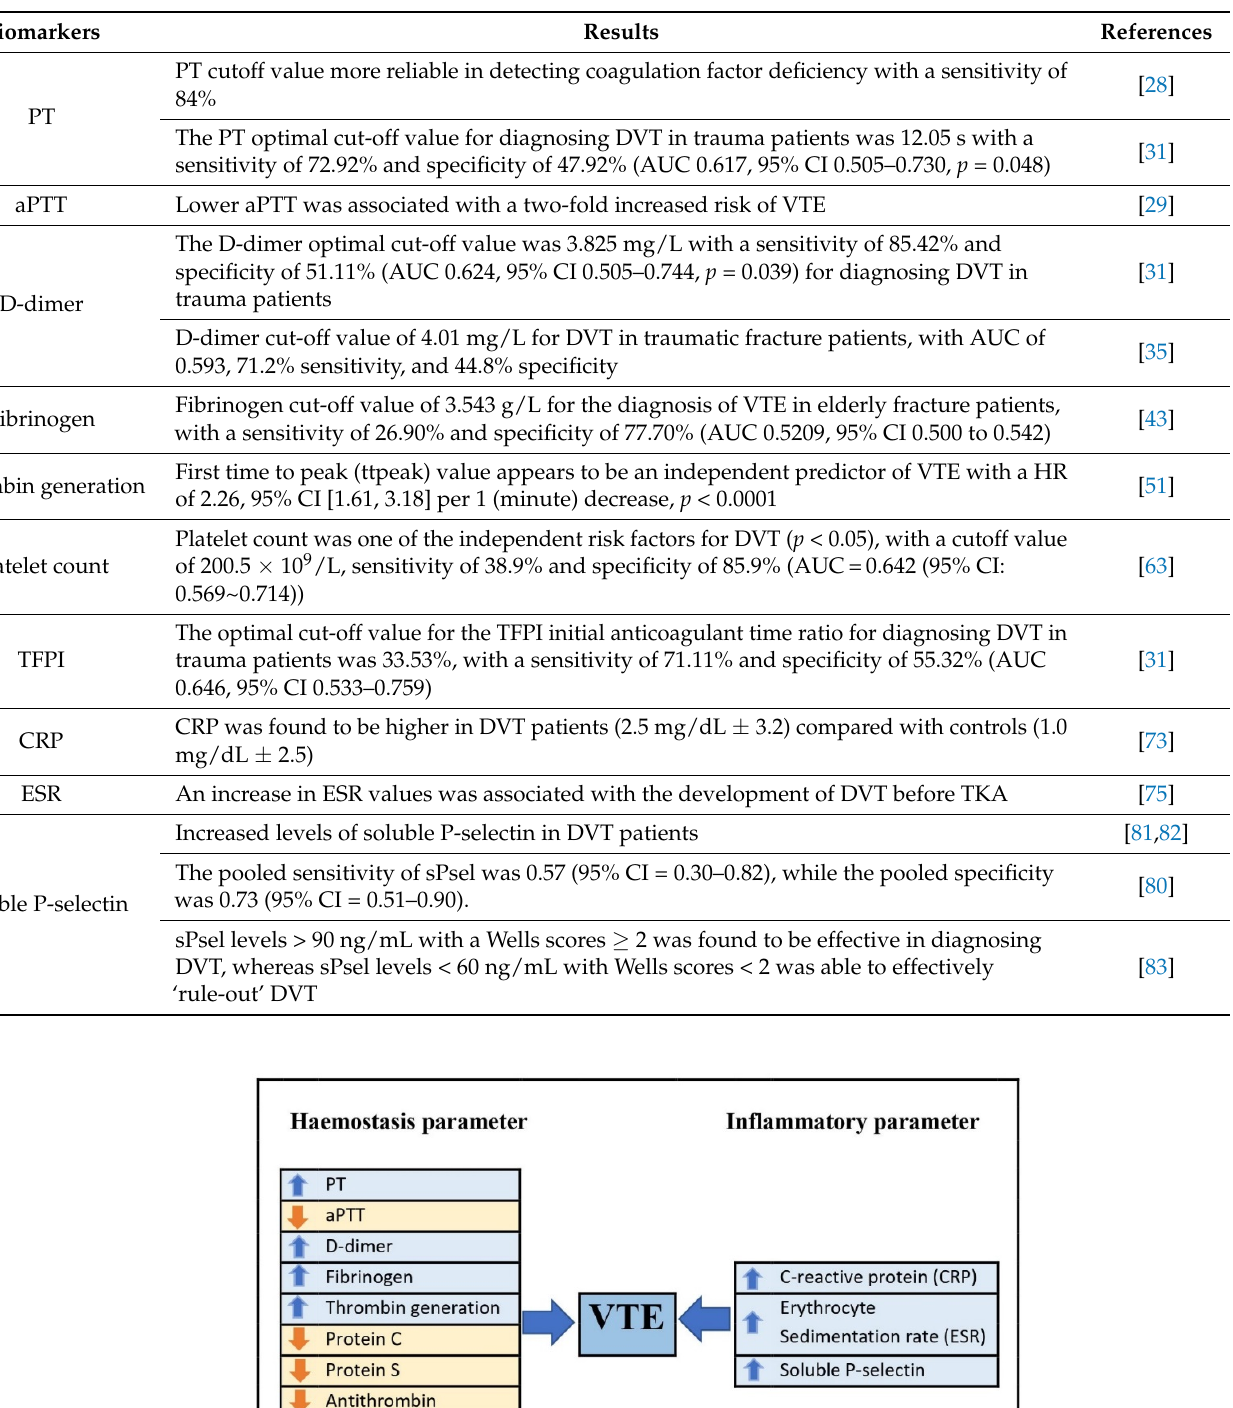
Table 1. Biomarker in predicting the risk of VTE.